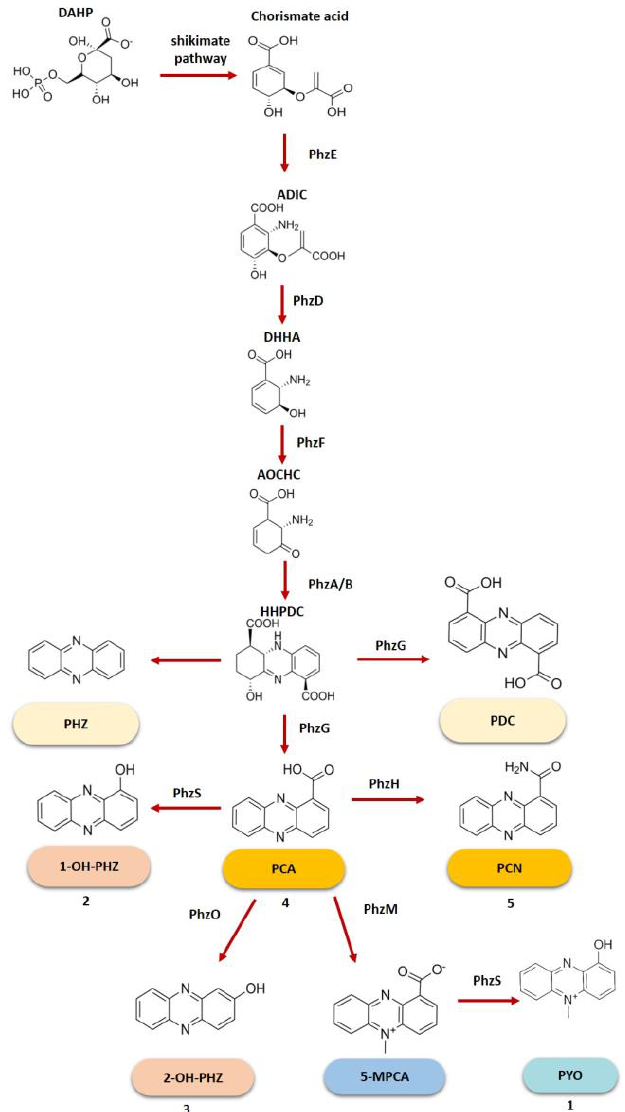
Figure 3. Biosynthetic pathway for phenazine production by Pseudomonas spp. DAHP: 3-deoxy-d-arabino-heptulosonate 7-phosphate; ADIC: 2-amino-2-deoxyisochorismate; DHHA: trans 2,3-dihydro-3-hydroxyanthranilic acid; AOCHC: 6-amino-5-oxocyclohex-2-ene-1-carboxylic acid; HHPDC: hexahydro-phenazine-1,6-dicarboxylate; PHZ: phenazines; PDC: phenazine-1,6-dicarboxylic acid; PCA: 4 phenazine-1-carboxylic acid; 1-OH-PHZ: 2 1-hydroxy-phenazine; PCN: 5 phenazine-1-carboxamide; 2-OH-PHZ: 3 2-hydroxy-phenazine; 5-MPCA: 5-methylphenazine 1-carboxylato; PYO: 1 pyocianin.